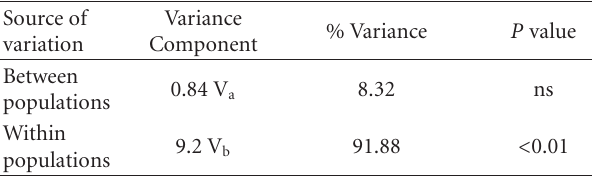
Table 3: Result of AMOVA for two groups of pheasants.